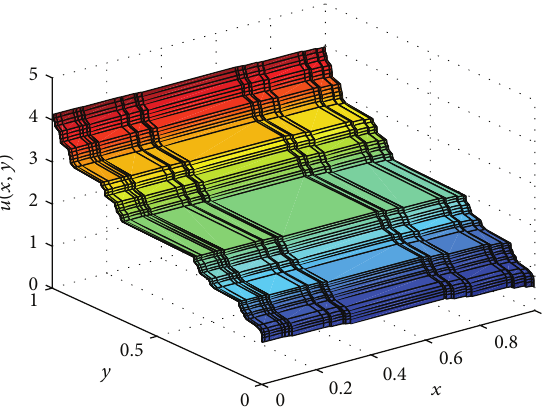
Figure 2: Plot of the nondifferentiable solution of (27) with the parameter 𝛼 = ln 2/ ln 3